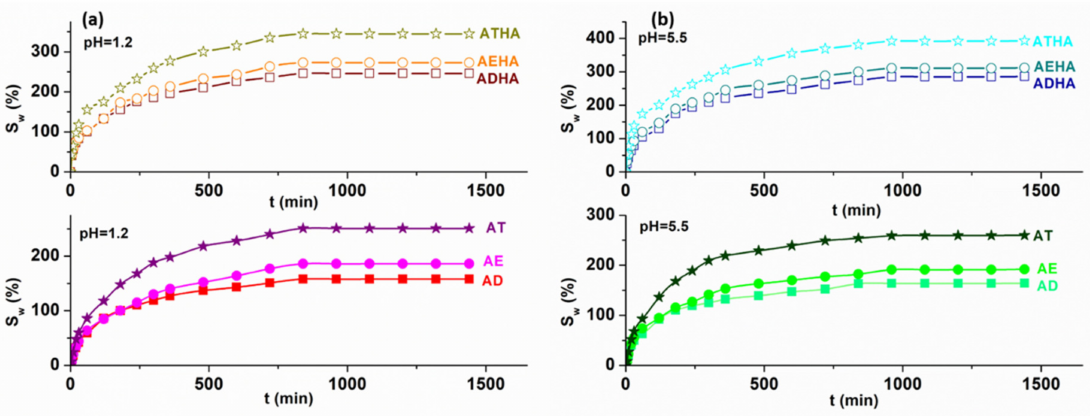
Figure 10. Time dependence of the degree of swelling in pH = 1.2 ( a ) and pH = 5.5 ( b ) for precur- sor/hybrid